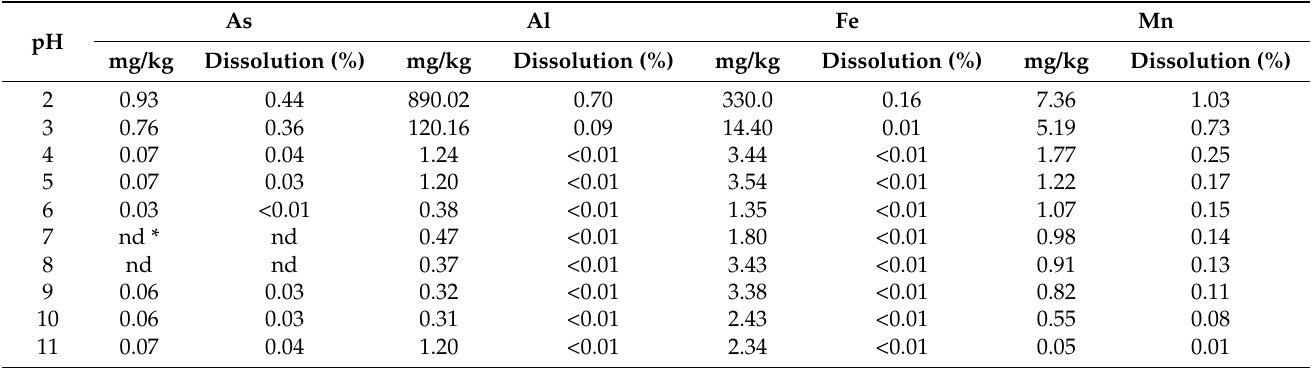
Table 5. Dissolution of As, Al, Fe, and Mn from FMNs in pH-static leaching